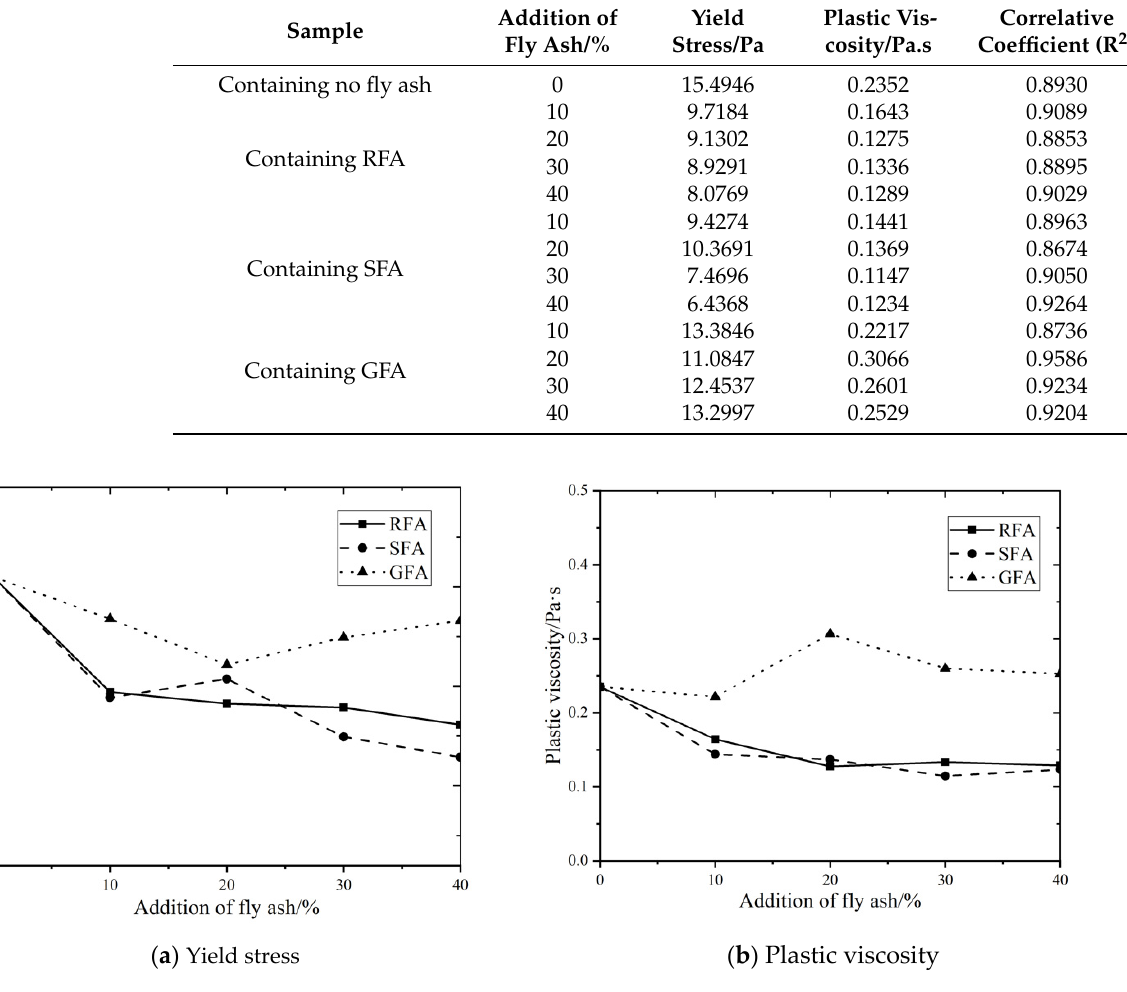
Table 5. Rheological parameters of cement paste containing different fly ash.